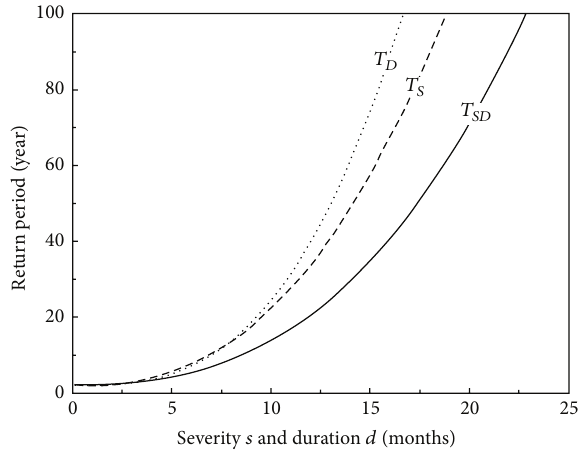
Figure 9: Univariate return period of severity 𝑇 𝑆 (18) and duration 𝑇 𝐷 (19) in terms of year plotted together with the bivariate severity and duration return period 𝑇 𝑆𝐷 (20) in terms of year for SPI3